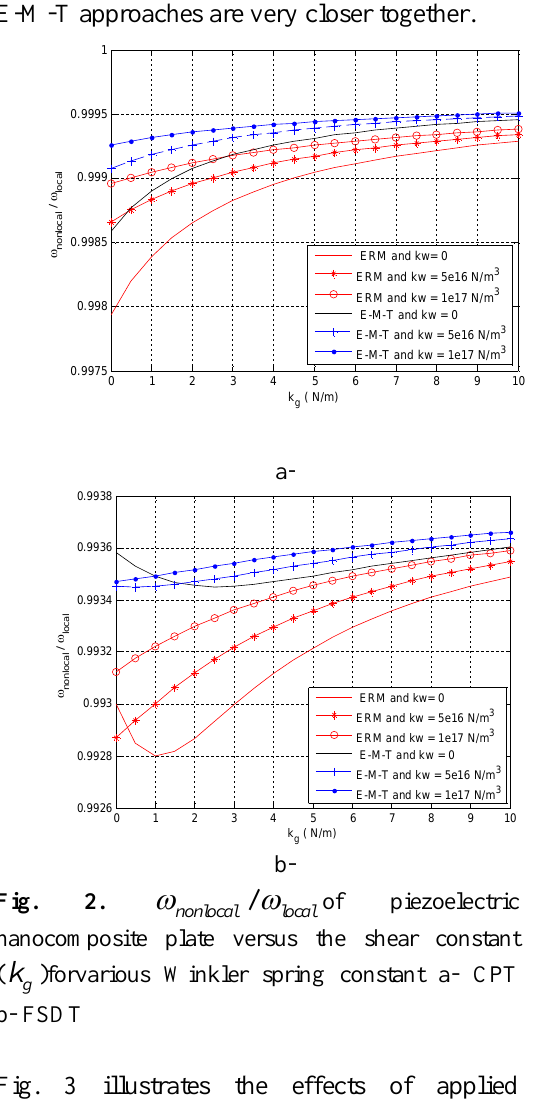
of applied   of piezoelectric Fig. 3. / nonlocal local on nanocomposite plate with respect to magnetic field intensity for various applied voltages a- CPT b- FSDT Effects of nano-plate residual surface stress  ) and surface Lame constants ( E ) on ( s s surface fundamental frequency to non-surface   ) are fundamental frequency ( / surface nonsurface displayed in Figs. 4. It can be observed